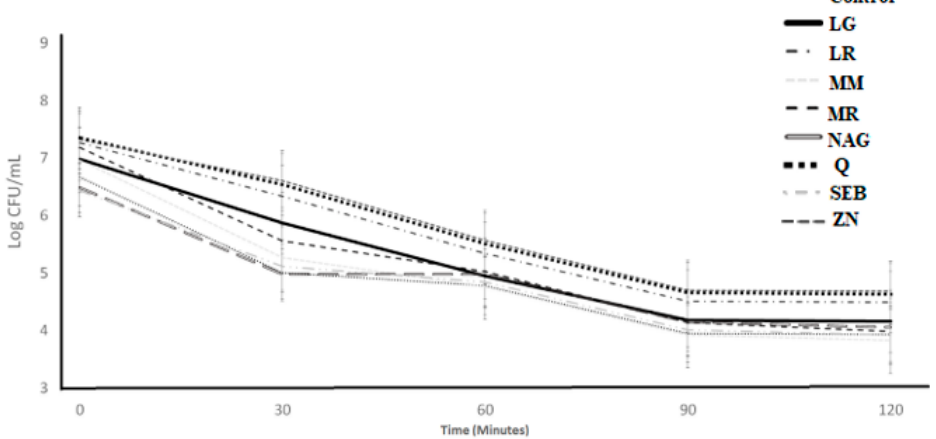
Figure 10. Log counts of Lactobacillus bulgaricus showing its resistance to lysozyme as influenced by ingredients during an incubation time of 120 min. C = control, LG = L-glutamine (7 g/L), Q = quercetin (700 mg/L), SEB = slippery elm bark (210 mg/L), MR = marshmallow root (1340 mg/L), NAG = N-acetyl-D-glucosamine (210 mg/L), LR = licorice root (210 mg/L), MM = maitake mushrooms (42 mg/L), and ZN = zinc orotate (70 mg/L). Error bars represent SE.